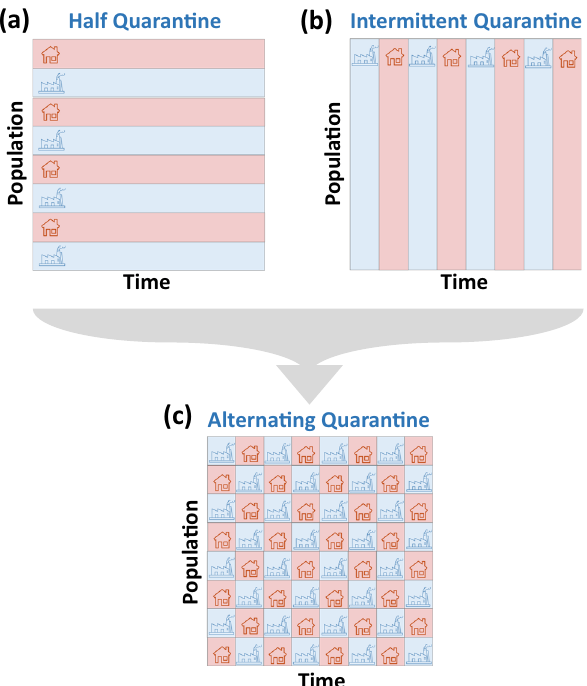
Fig. 5 The multiplicative effect of alternating quarantine. We consider three strategies — all allowing socioeconomic activity (blue) vs. quarantine (red) at half capacity. a The Half quarantine strategy reduces infection by diluting the active population, hence decreasing the rate of infectious interactions. b Intermittent quarantines achieve a similar outcome by diminishing the duration of the activity, hence reducing the time of infectious interactions. c Alternating quarantine combines both effects: on the one hand interactions are limited to individuals within each cohort — diluting the population. On the other hand, these cohorts experience intermittent cycles of work/home — diminishing interaction duration. The result is a ~fourfold reduction in transmission, alongside a mere 50% reduction in socioeconomic